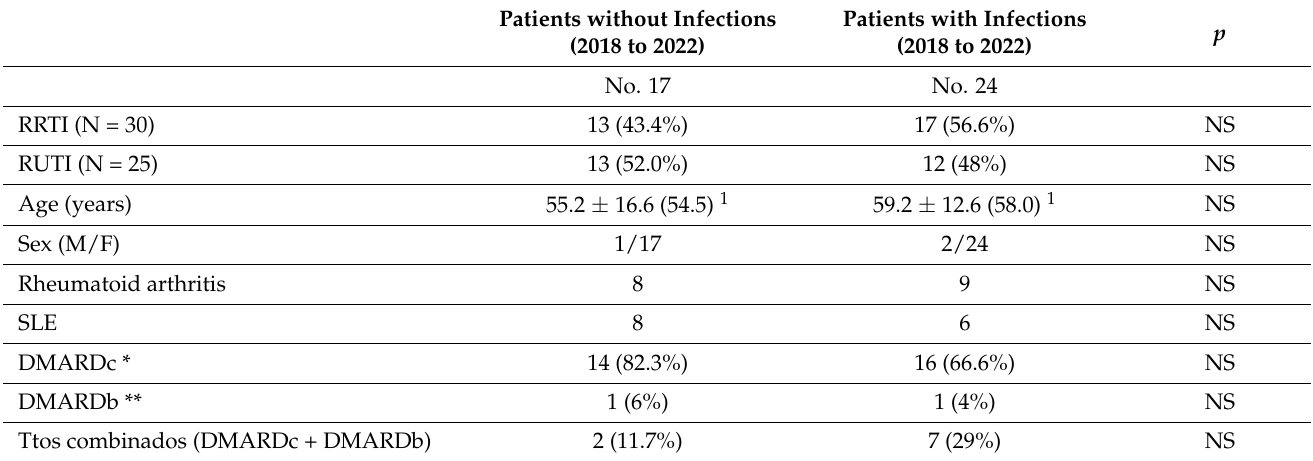
Table 2. Comparison of the whole SAD cohort, dividing patients according to clinical outcome during the 3-year period of follow up. As shown, 14 patients overlapped RRTI and RUTI. No (%). 1 mean ± edm